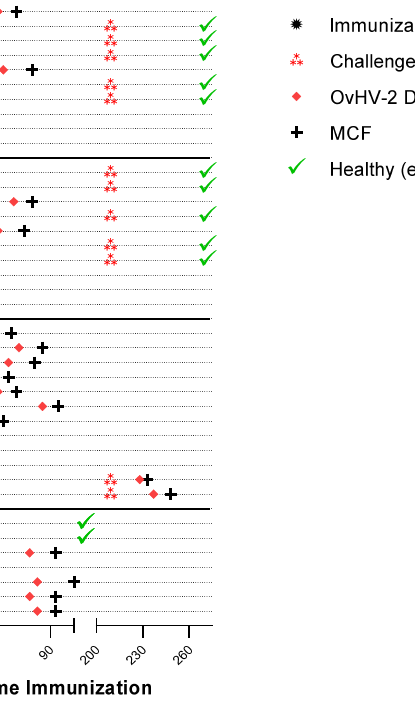
Figure 1. Schematic representation of treatments (immunizations and OvHV-2 challenge) and infection/disease outcomes.